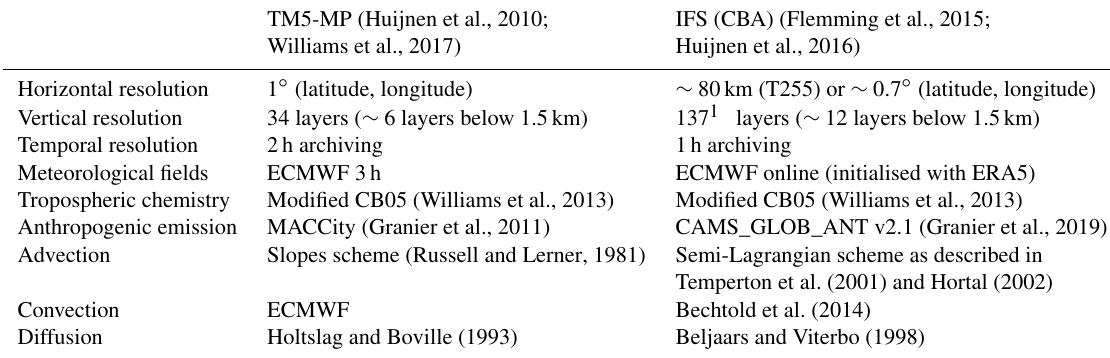
Table 2. Summary of the chemistry transport model